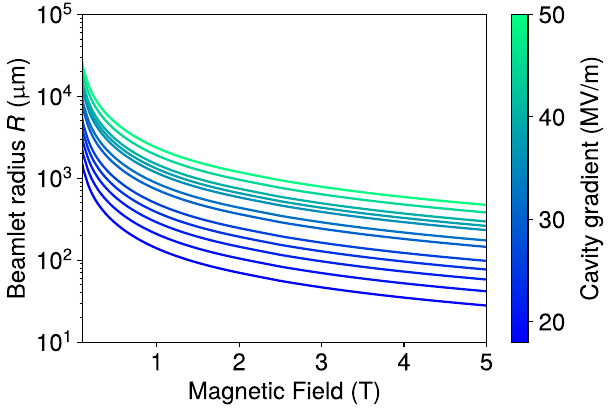
FIG. 1. Beamlet radius on impact vs magnetic field for a range of (copper) cavity gradients, assuming a prolate spheroidal emitter 1 . 77 μ m wide and 62 . 0 μ m long, consistent with β ¼ 385 . Space charge imposes a lower limit on beamlet size, even at very large magnetic fields.